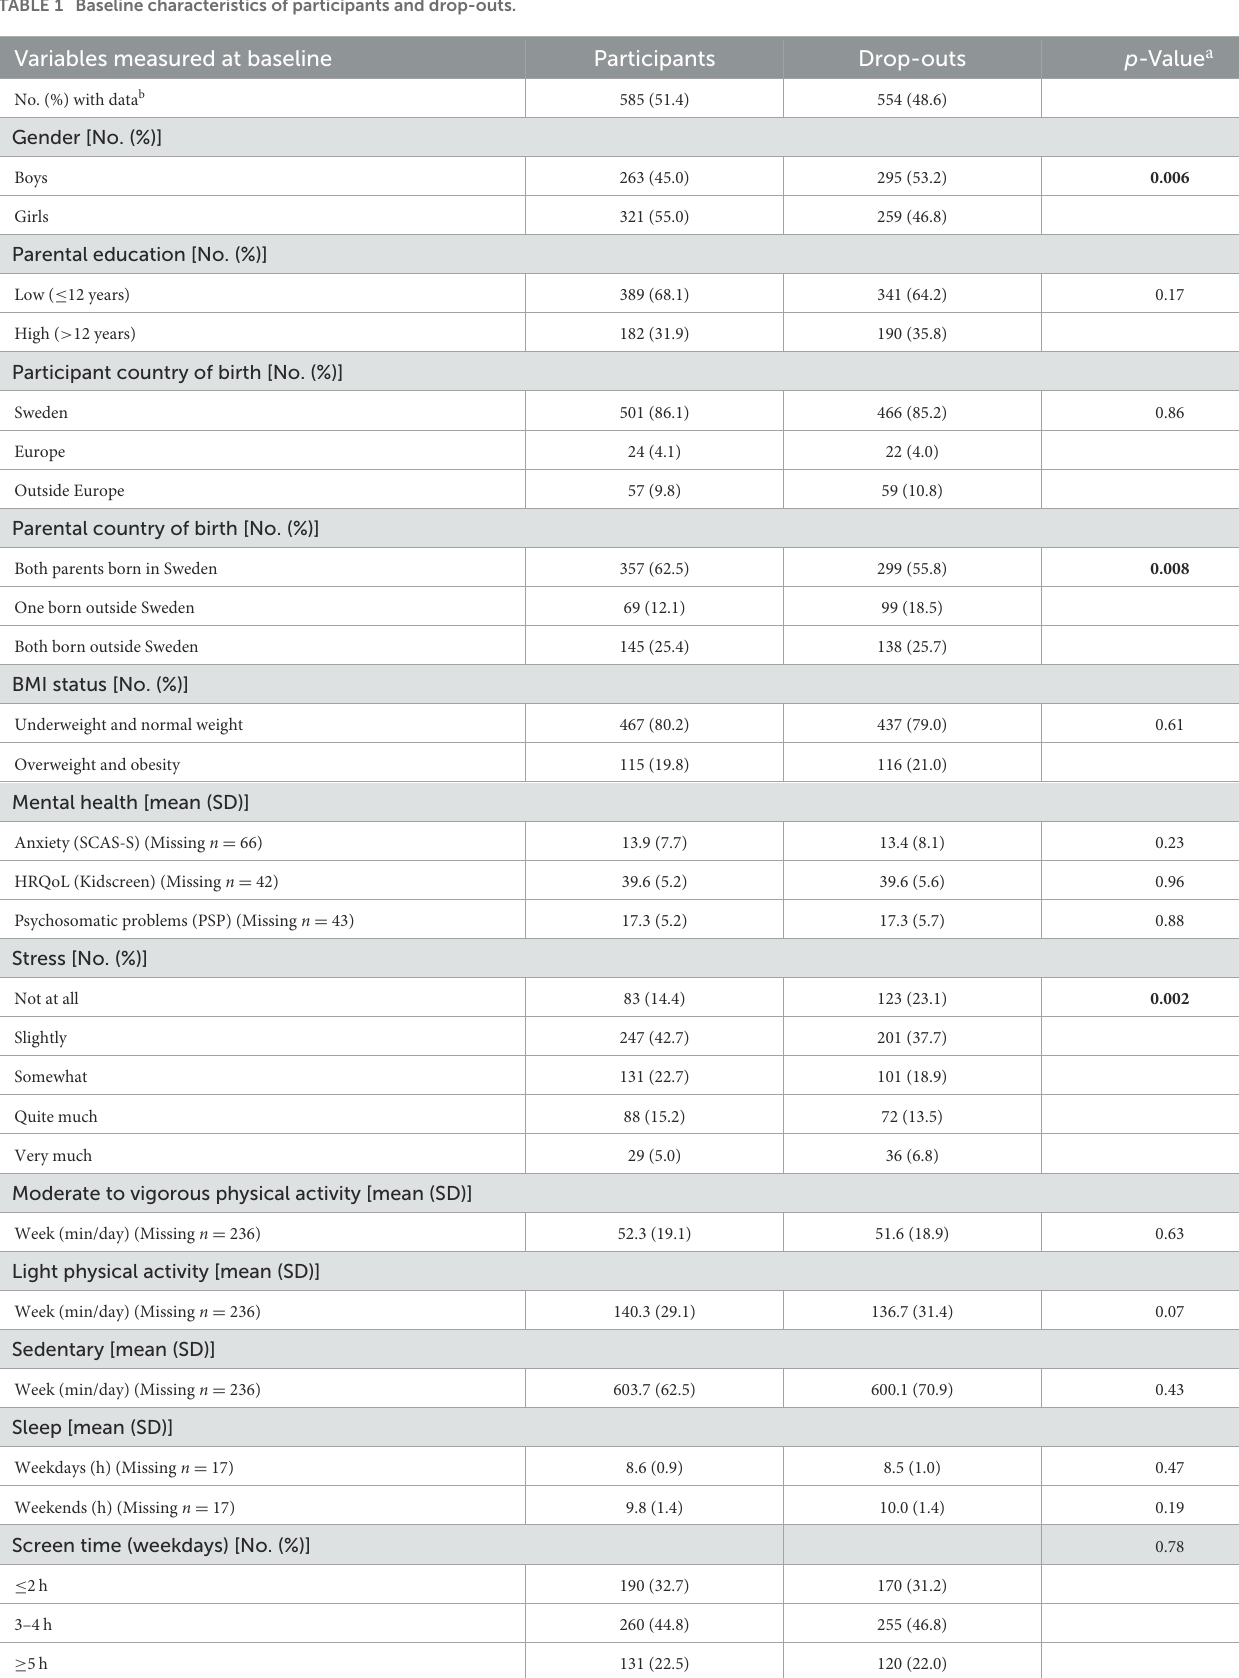
TABLE 1 Baseline characteristics of participants and